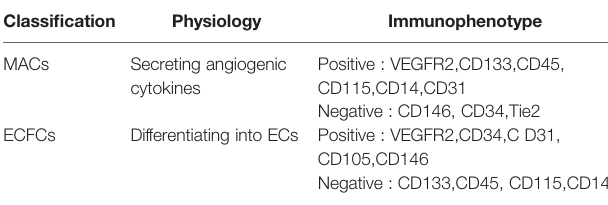
TABLE 1 | Classi fi cation, immunophenotype and physiology of EPCs.